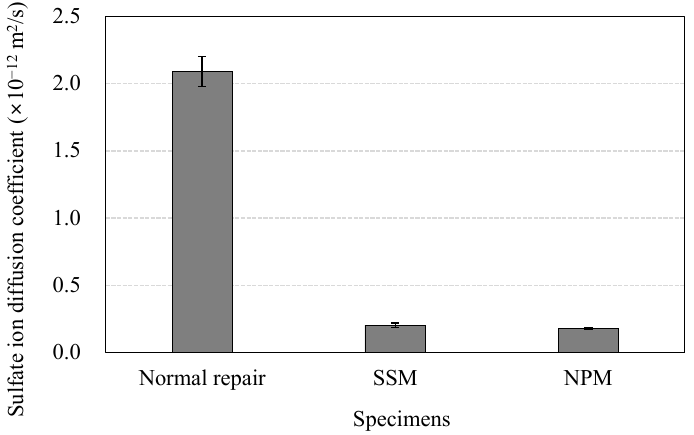
Figure 12. Results of the sulfate ion diffusion coefficient.